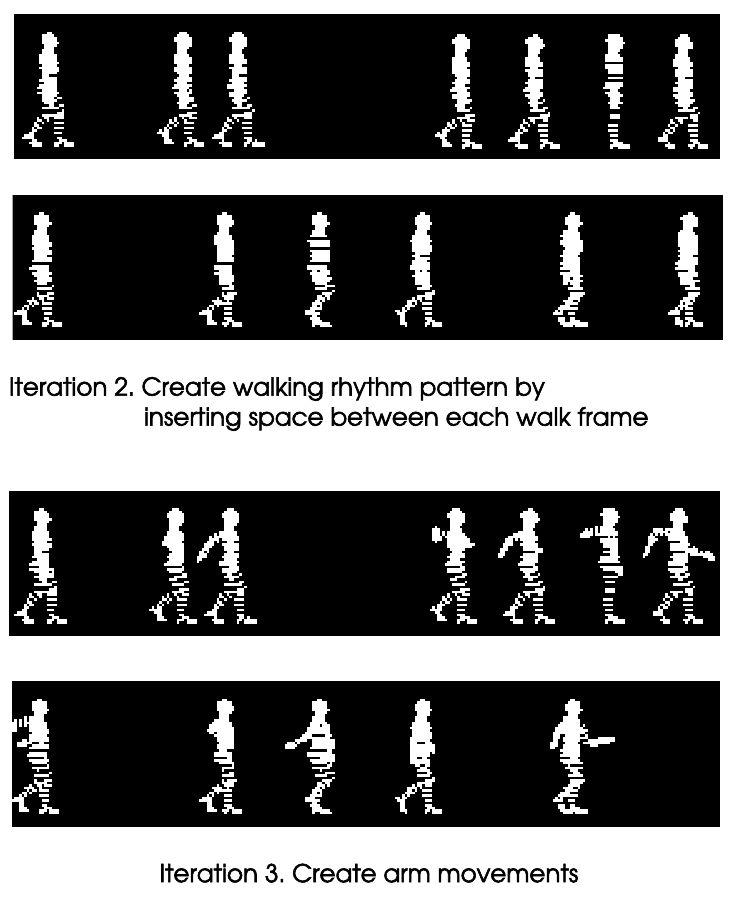
Figure 4.14. Excerpts from the stages of creating the Walker